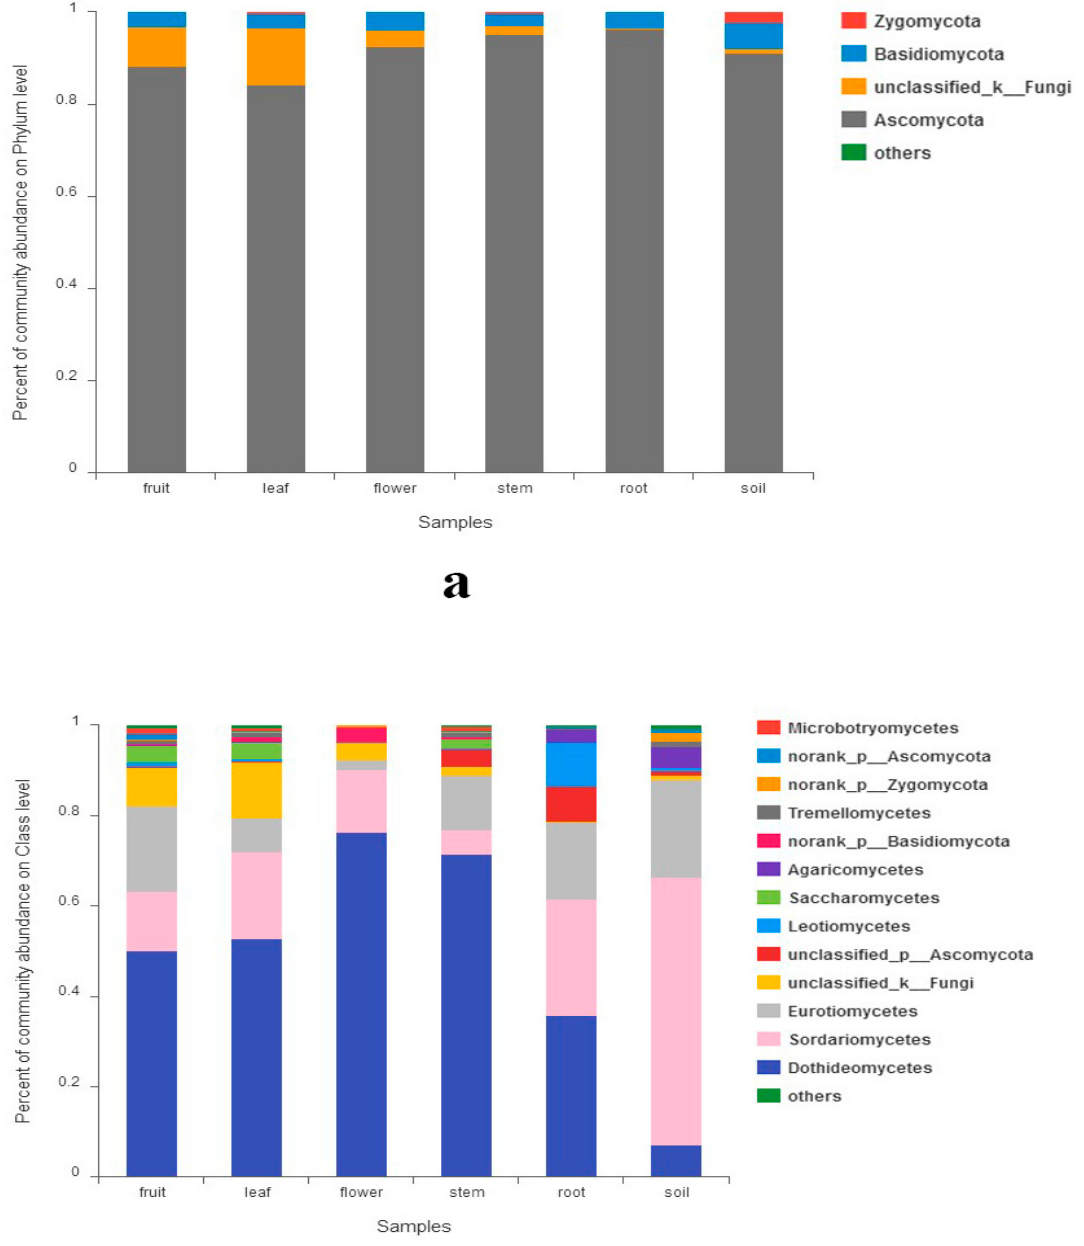
Figure 1. Fungal abundance in different organs and soil: ( a ) at phylum level; ( b ) at class